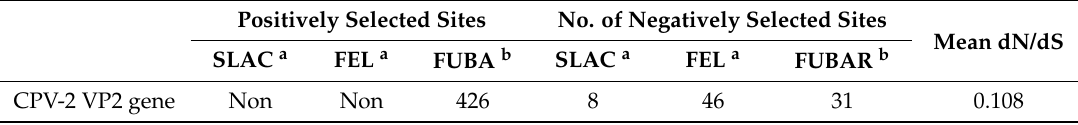
Table 3. Selection Pressure Detected in CPV-2 VP2 Protein Gene. Positively Selected Sites